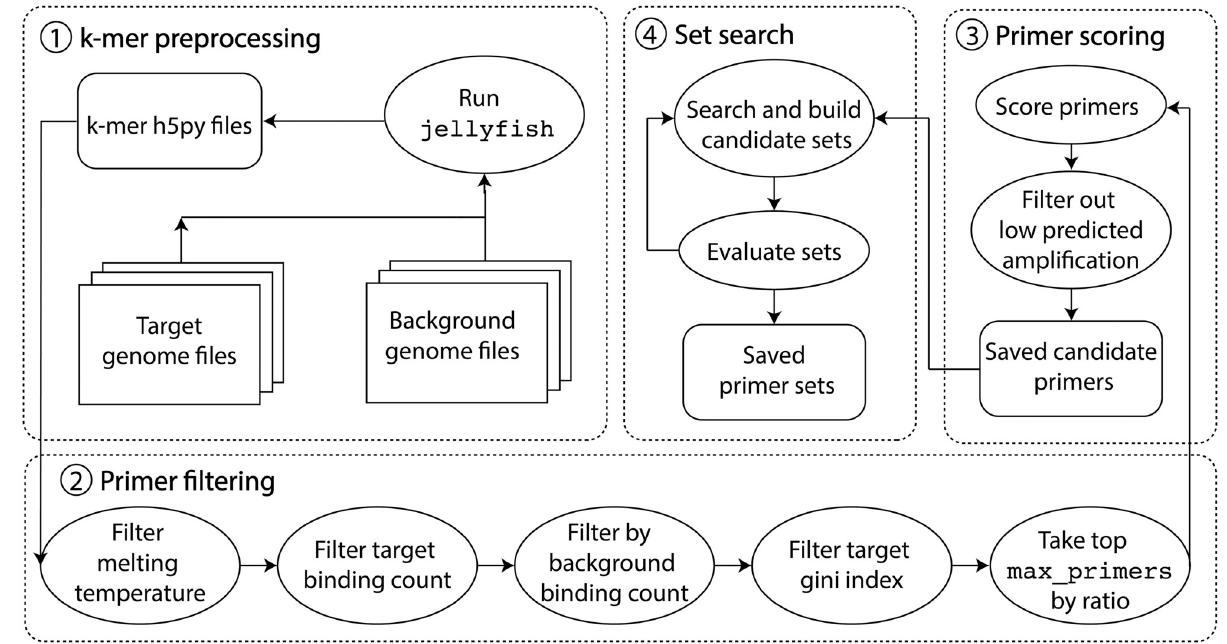
Fig 1. Overview of the swga2.0 pipeline. The process is broken into four stages: 1) preprocessing of locations in the target and off-target genomes, 2) filtering motifs in the target genome based on individual primer properties and frequencies in the genomes, 3) scoring the remaining primers for amplification efficacy using a machine learning model, and 4) searching and evaluating aggregations of primers as candidate primer